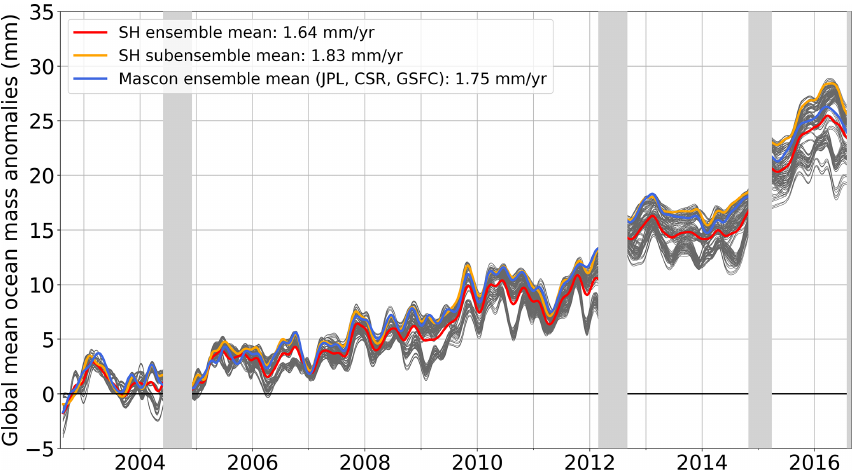
Figure A1. Comparison of global mean ocean mass changes from satellite gravimetry based on spherical harmonics solutions (LEGOS ensemble V1.4, in grey) and mascon solutions over August 2002–August 2016 for the global ocean. The mean of the full spherical harmonic ensemble is shown in red. The mean of the spherical harmonic ensemble subset consistent with mascons is shown in orange. The mean of the three mascon solutions considered in this study is shown in blue.